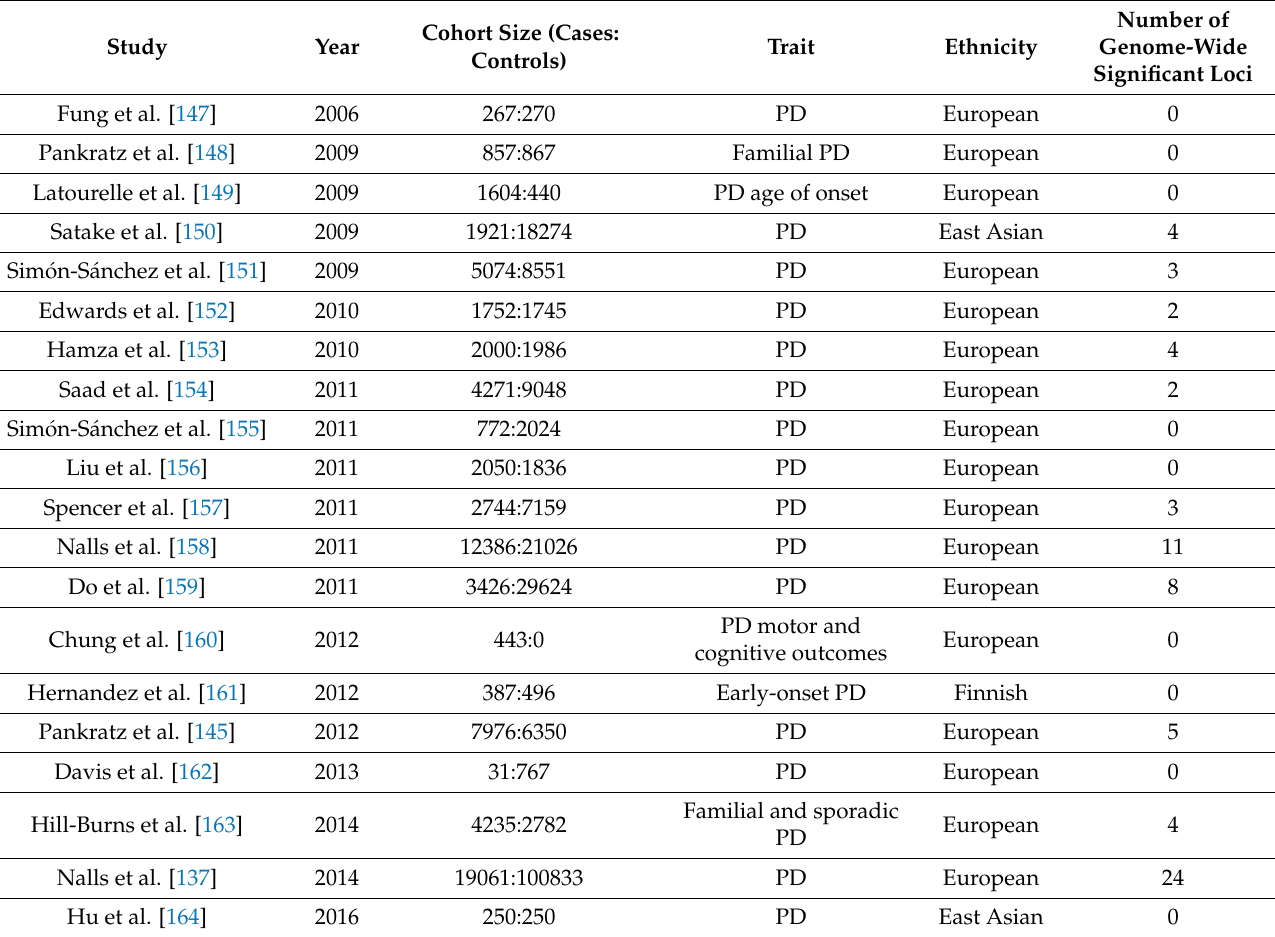
Table 2. Summary of idiopathic Parkinson’s disease GWA studies included in NHGRI-EBI Catalog of human genome-wide association